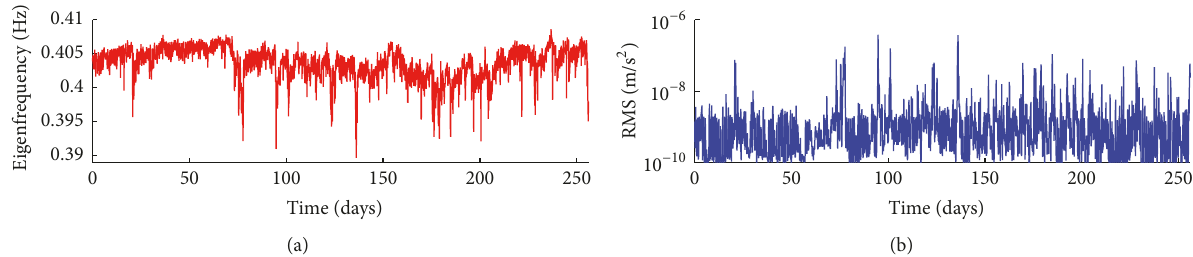
Figure 16: Experimental trend of the second eigenfrequency (a) and the vibration RMS at floor 37 in 𝑥 direction (see Figure 1) calculated on the frequency range of the second eigenfrequency